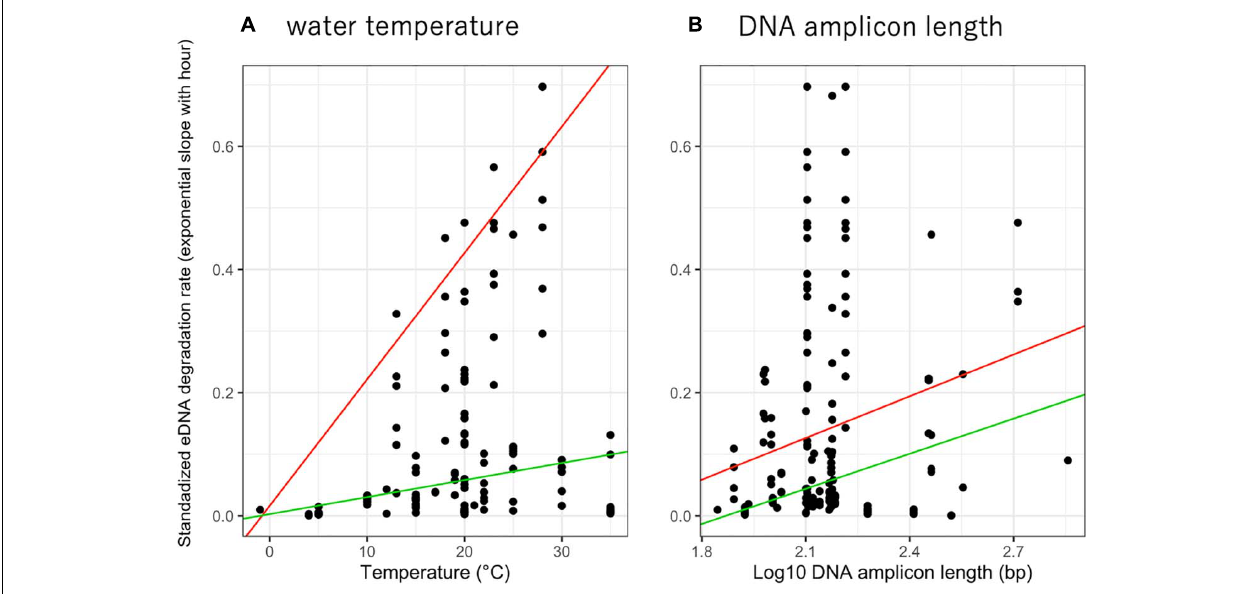
FIGURE 2 | The relationship between standardized eDNA degradation rate per hour (simple exponential slope) with (A) water temperature and (B) DNA amplicon length. The red and green lines show 0.95 and 0.5- quantile mixed-effect quantile models for each factor.